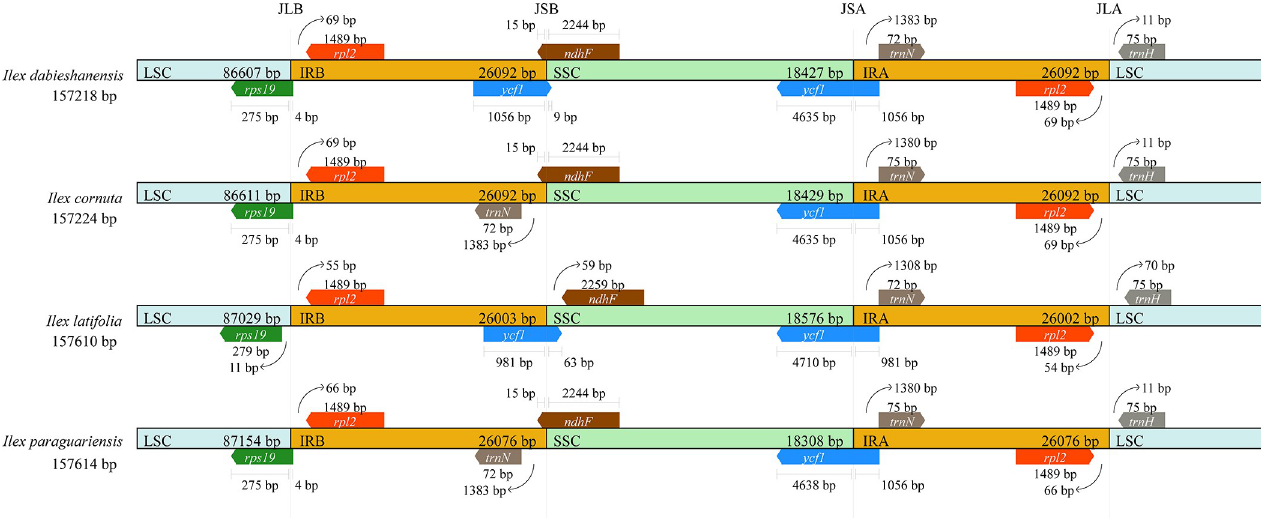
Fig 5. Comparisions of the SSC/IRs and LSC/IRs junctions among four Ilex chloroplast genomes. Colored boxes above the strip with scaled sequence length represent the denoted genes. Between boxed genes and boundaries are the gaps in base length (bp). JLB, JSB, JSA, and JLA indicate IRB/LSC, IRB/SSC, IRA/SSC, and IRA/LSC junctions,